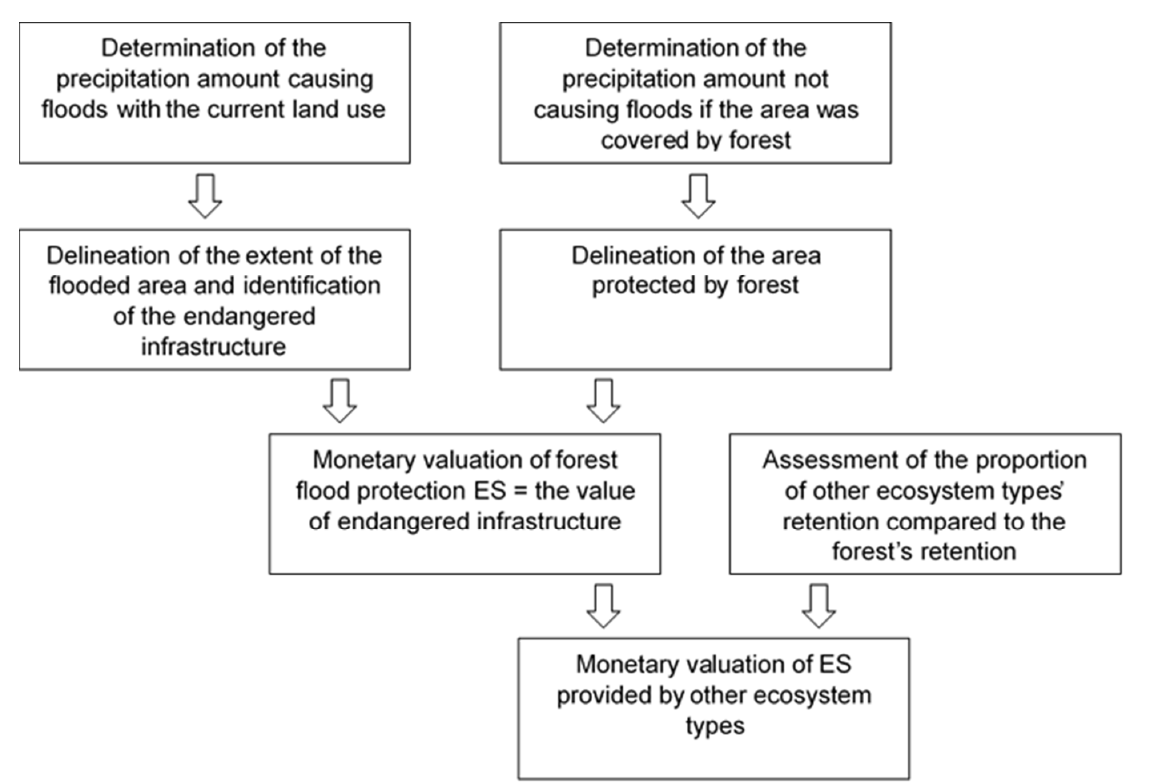
Figure 3. Methodical steps of the assessment.